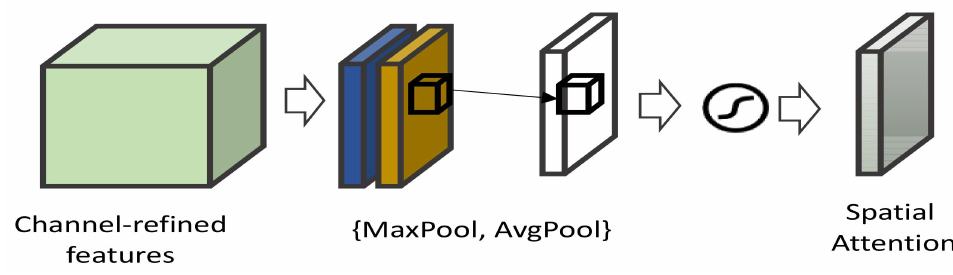
Figure 13. Illustration of STN